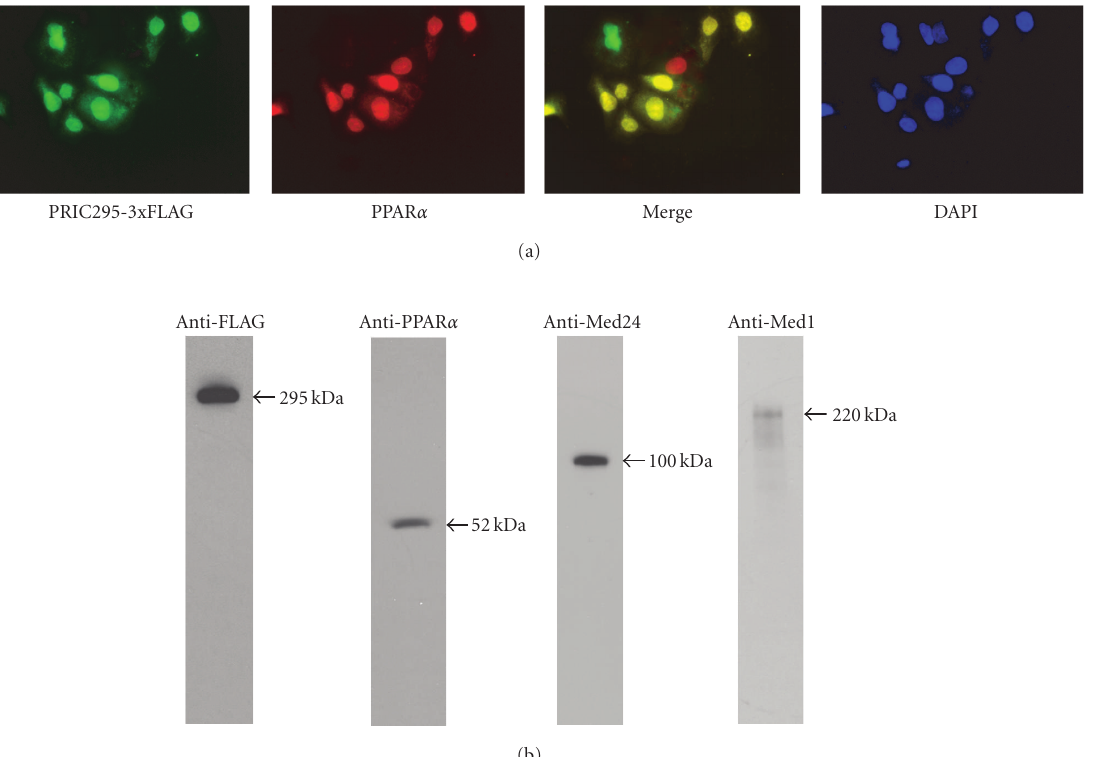
Figure 8: Intracellular localization of PRIC295. (a) Immunofluorescence microscopy to visualize intracellular localization of PRIC295- 3xFLAG and PPAR α in HeLa cancer cells after transfection with pcDNA-PRIC295-3xFLAG and pCMX-PPAR α . Anti-FLAG M2 monoclonal antibody was used for PRIC295-3xFLAG (green color), and anti-PPAR α antibody was used to stain PPAR α (red color). DAPI nuclear stain is for the visualization of cells in the field. Merged image of PRIC295-3xFLAG (green) and PPAR α (red) reveals yellow coloration of nuclei that coexpress both proteins. The presence of a green and red cell in the merged panel is an indication that these cells are not likely transfected with both plasmids. (b) Immunoprecipitation data showing purified PRIC295-3xFLAG protein and coimmunoprecipitated proteins PPAR α , Med24/TRAP100, and Med1. Cells were transfected with pcDNA-PRIC295-3xFLAG